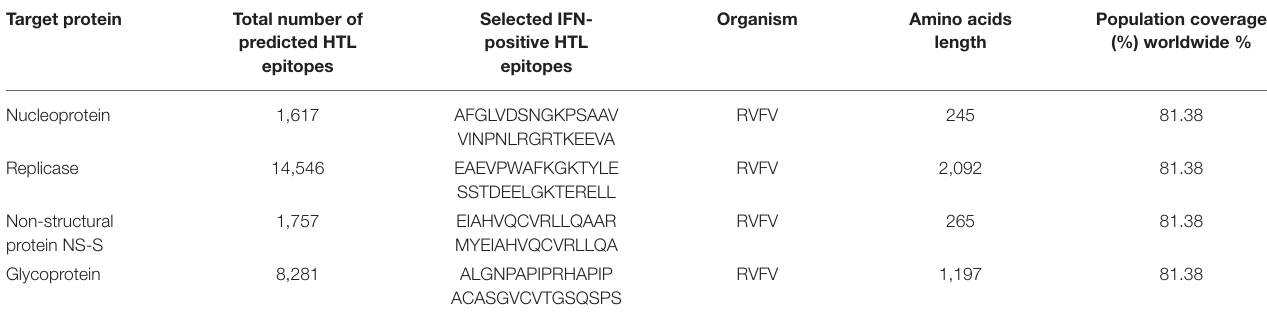
TABLE 4 | Details of total identified HTL epitopes and shortlisted ones for the vaccine design against each target protein of RVFV.